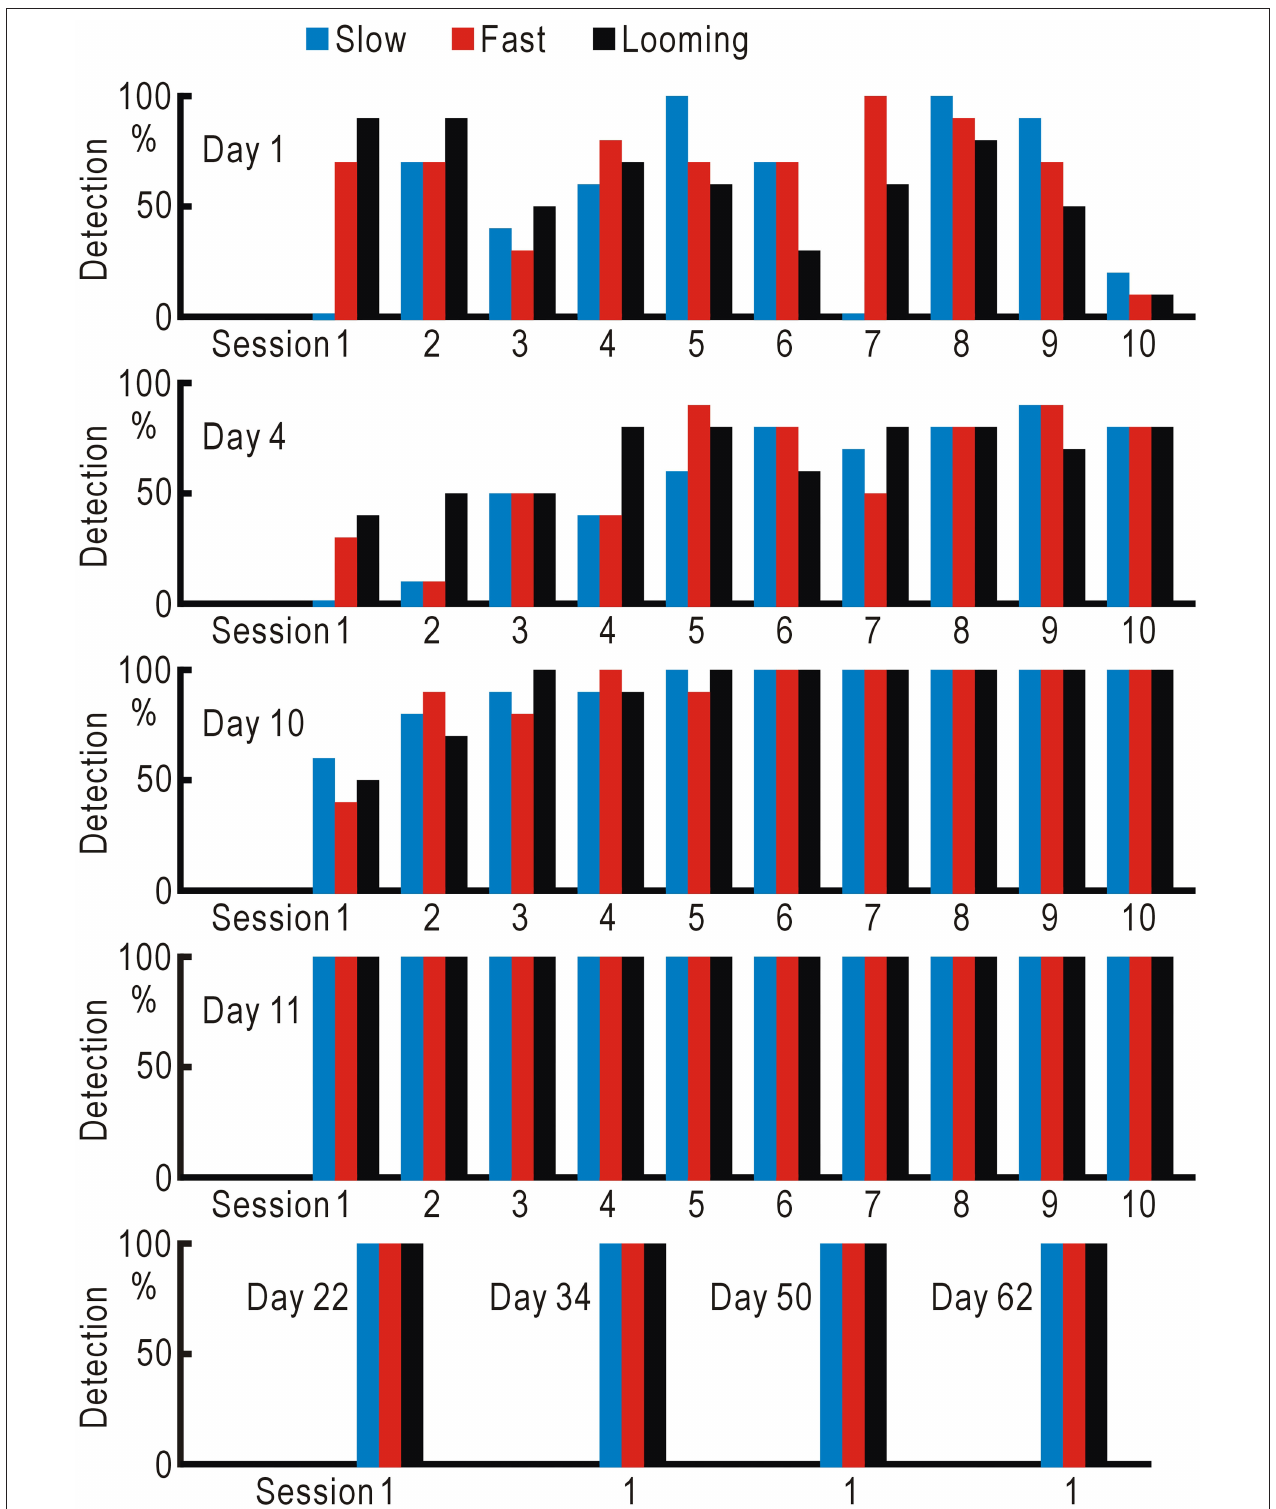
FIGURE 4 | Training using the visual field test without gaze check tasks for the hemianopic patient. Slow (gradually appearing disc), fast (suddenly appearing and gradually disappearing disc), and looming (gradually enlarging disc) stimuli were repeatedly presented in 10 trials each, and the detection probabilities of the three types of stimuli were